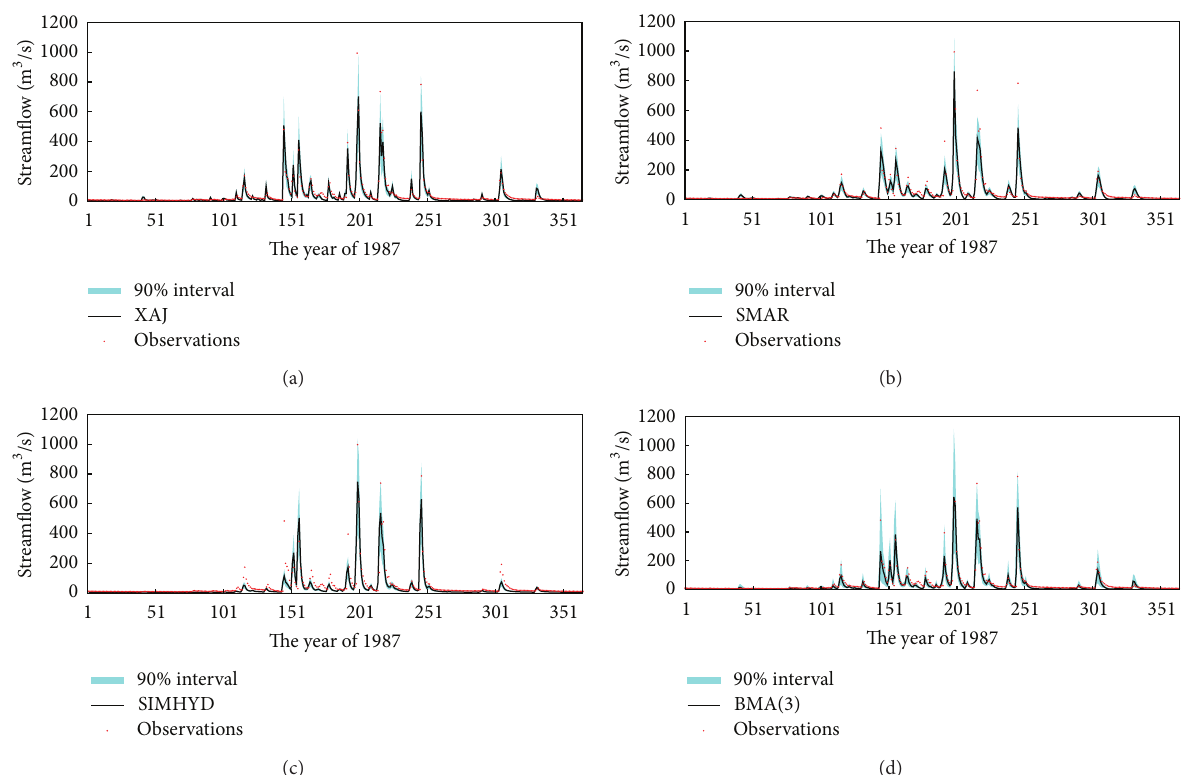
Figure 7: The mean prediction and 90% confidence interval of both BMA(3) and 3 individual models for the Mumahe catchment in 1987 during the validation period.